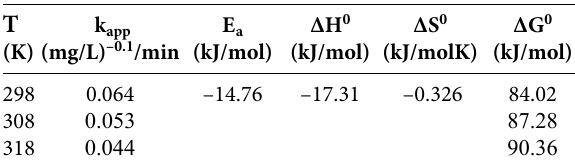
Table 2. Kinetic and thermodynamic parameters of the photocata- lytic degradation of DB-22